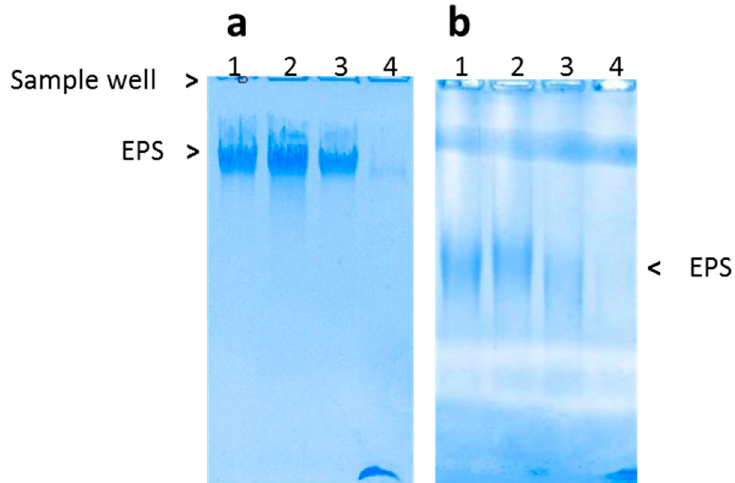
Figure 1. Examples of EPS production visualized by agarose gel electrophoresis ( a ) MA896B; ( b ) HE799. Growth medium: (1) glucose, (2) saccharose, (3) mannitol, and (4) ZPHUF alone.